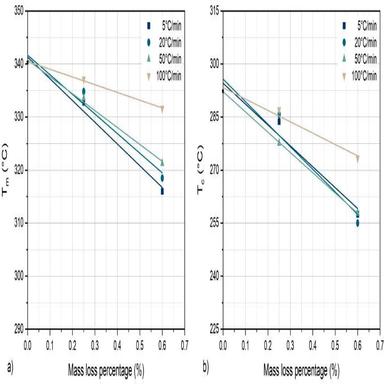
a) Tm and b) Tc of CF-PEEK as degradation progresses for the heating rates of 5, 20, 50 and 100 ◦C/min.